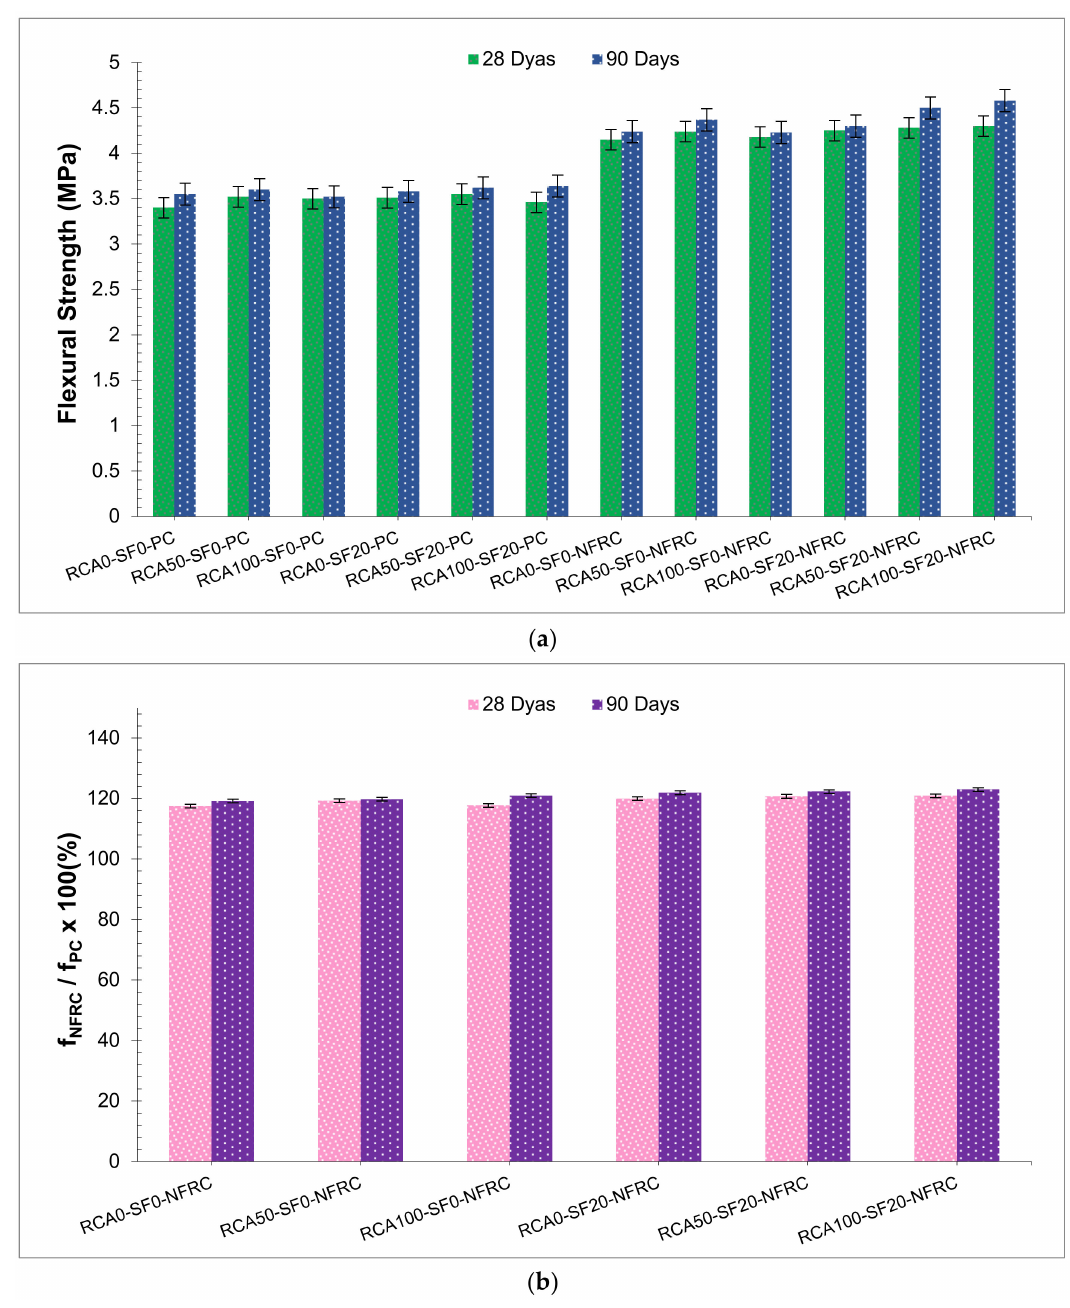
Figure 5. ( a ) Flexural Strength, ( b ) Flexural Strength of Each NFRC Mix w.r.t Plain Concrete